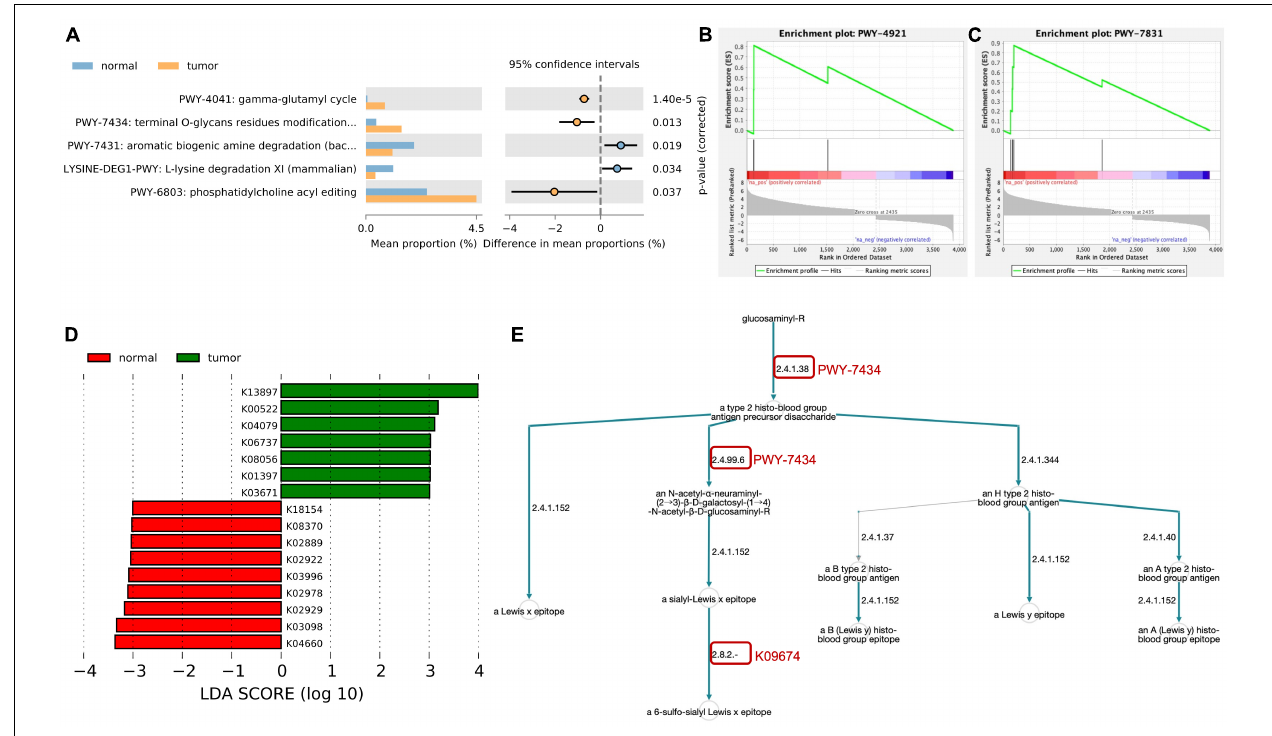
FIGURE 2 | Metabolic pathways enrichment analysis. (A) Metabolic pathways of the endometrial microbiota based on MetaCyc database. (B,C) MetaCyc-based GSEA functional enrichment analysis of human host. (D) Different KEGG orthology (KO) terms between EC and normal group. (E) Host–microbial metabolic pathway crosstalk. The red circle indicates the link of microorganisms involved in host metabolic pathway.